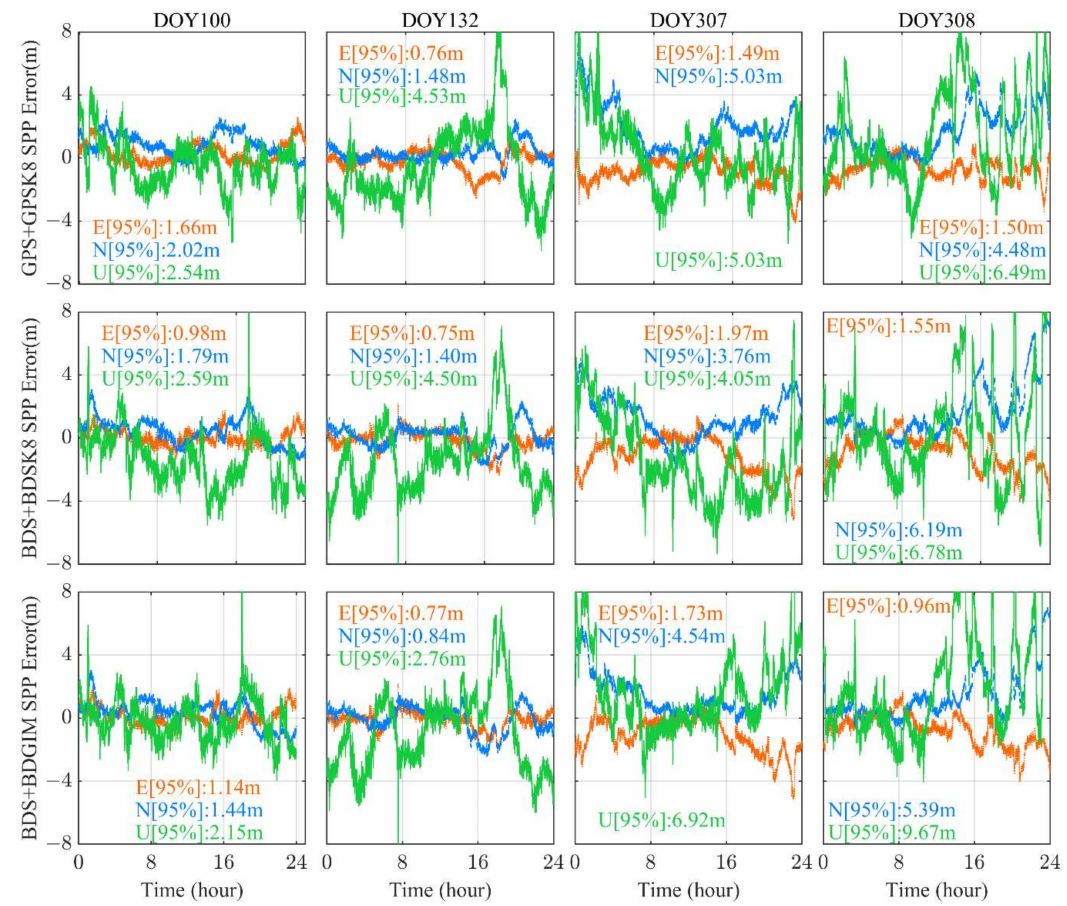
Figure 9. Time series of positioning errors at LMMF for GPS + GPSK8, BDS + BDSK8, and BDS + BDGIM with DOY 100 as a reference period and strong geomagnetic storms at DOY 132, 307, and 308. In each panel, the time series and statistical results correspond to the E, N, and U directions, denoted in red, blue, and green